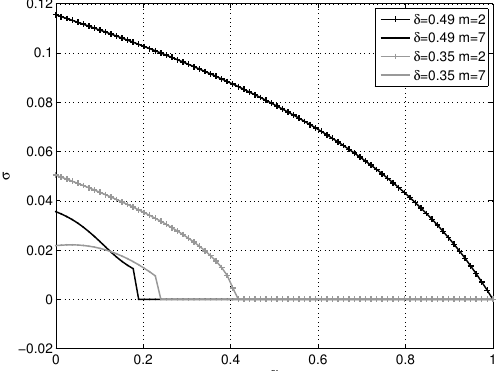
Figure 11. Evolution of the growth rate of the most unstable mode, σ , as the lower-layer flow evolves from the rest-state to the zero PV anomaly solution, for a lenticular vortex with zero PV in the upper layer. Vortex depth ratios δ = 0.49, 0.35 and azimuthal wave numbers m = 2, 7. No other unstable mode was